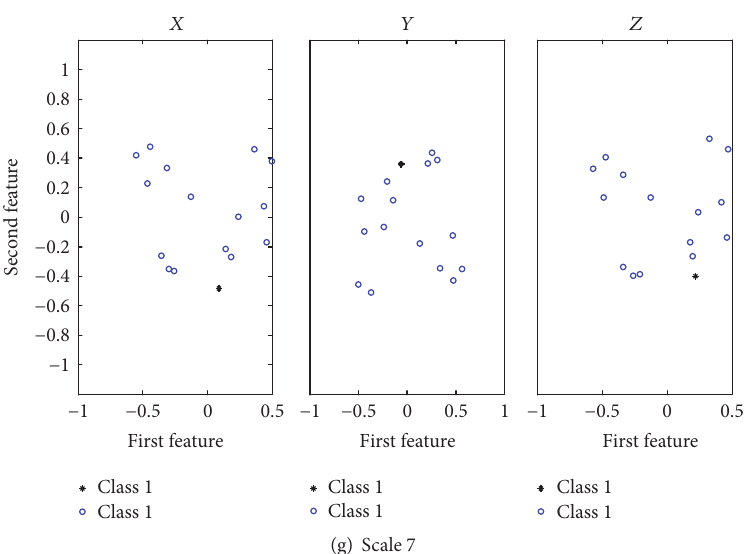
Figure 2: Clustering results using the proposed method at first seven scales.